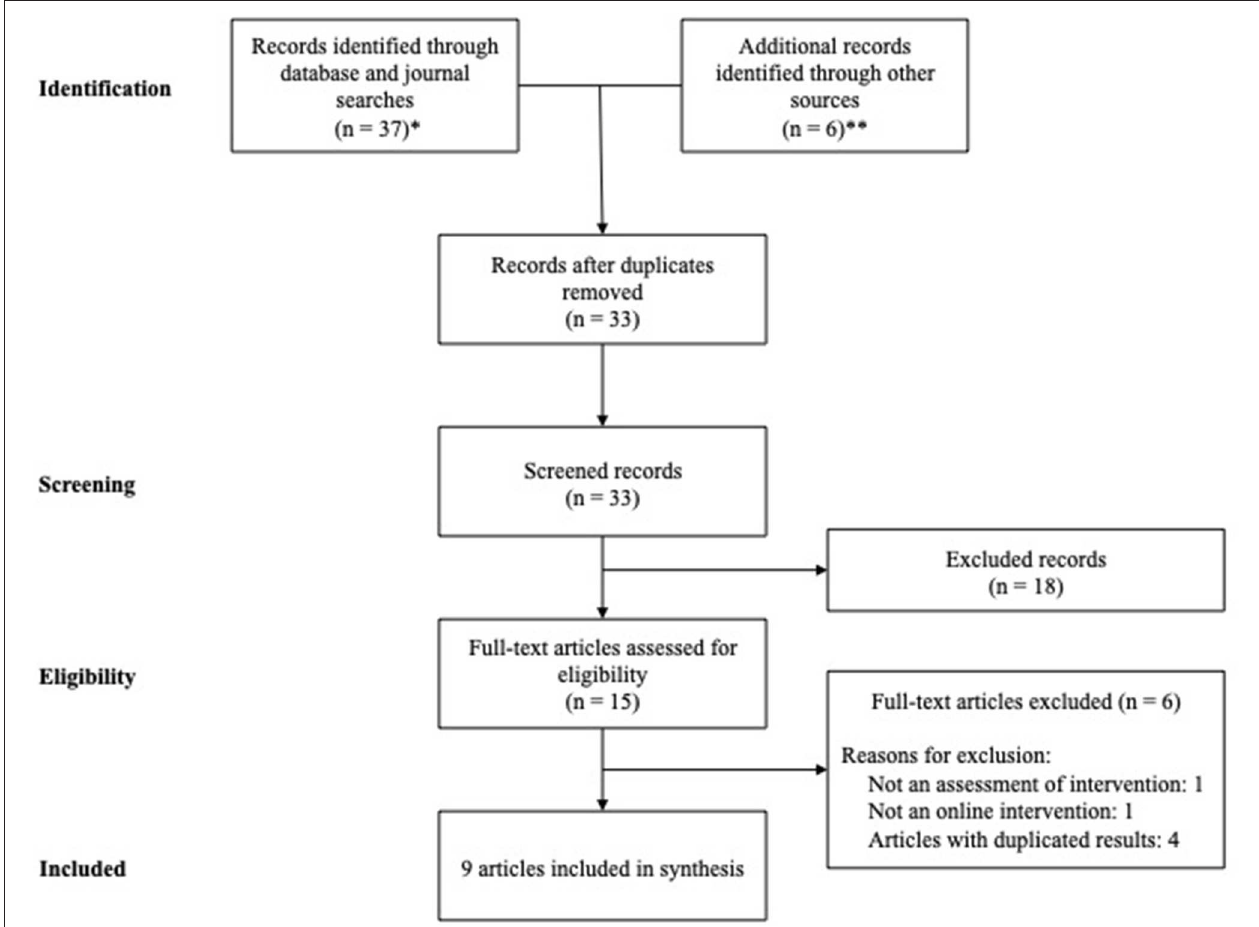
FIGURE 1 | PRISMA Flow diagram. *PubMed: 20 records; Embase: 12 records; Scielo: 5 records. **Presentations in scientific congresses: 2 presentations; Personal contact: 3 drafts of preliminary results; Reported in other review: